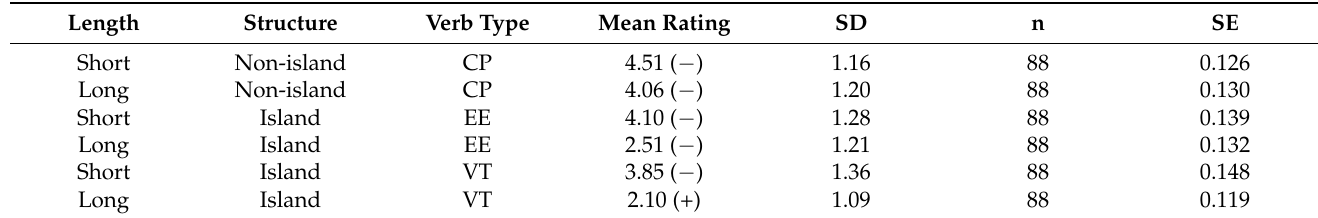
Table A5. Descriptive statistics for Experiment 3 burn-in trial results. A + or − in the rating cell (respectively) represents a higher or lower mean score for that condition in the burn-in trials than in the main trials. Mean is calculated on raw (non-z-scored) ratings.